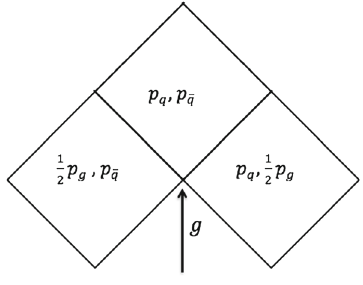
Fig. 10 Parameter plane for a qg ¯ q